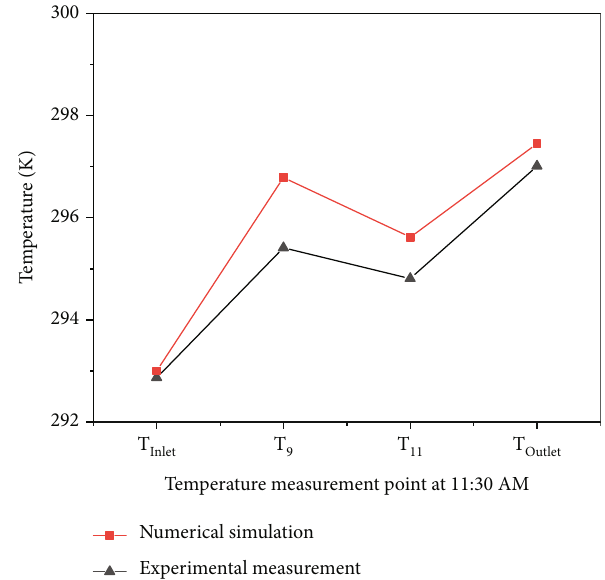
Figure 3: Temperature comparison of di ff erent measurement points between experimental measurements and numerical